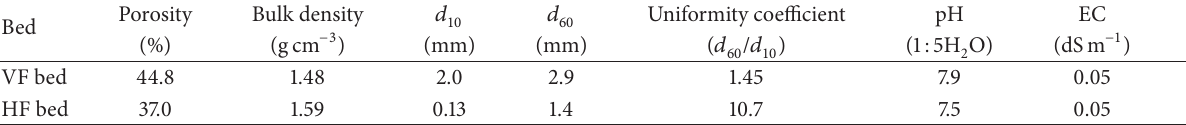
Table 2: Physicochemical characteristics of filter media used.